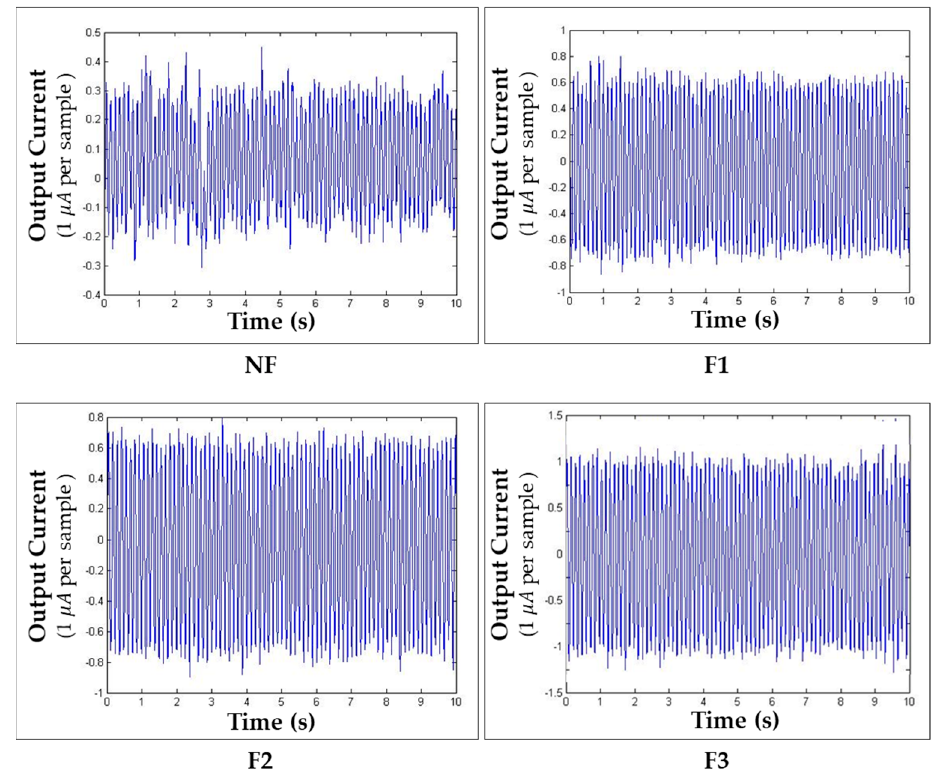
Figure 14. Output current corresponding to time according to the foaming conditions of IPMC: 8 Hz, 1 V.